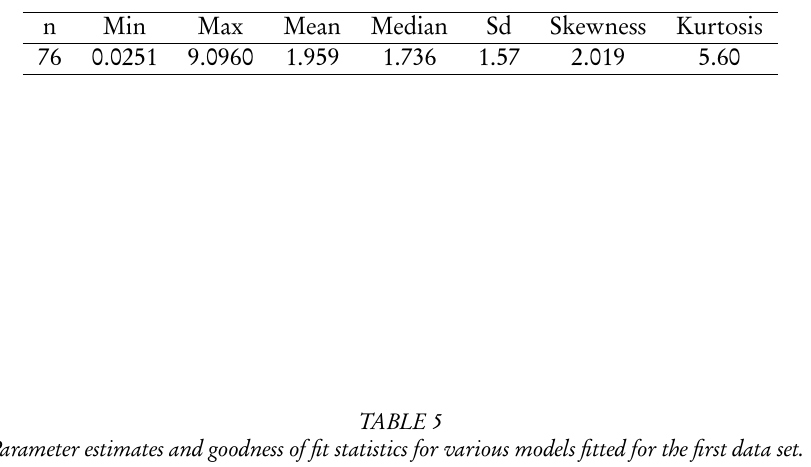
Descriptive statistics of first data set.